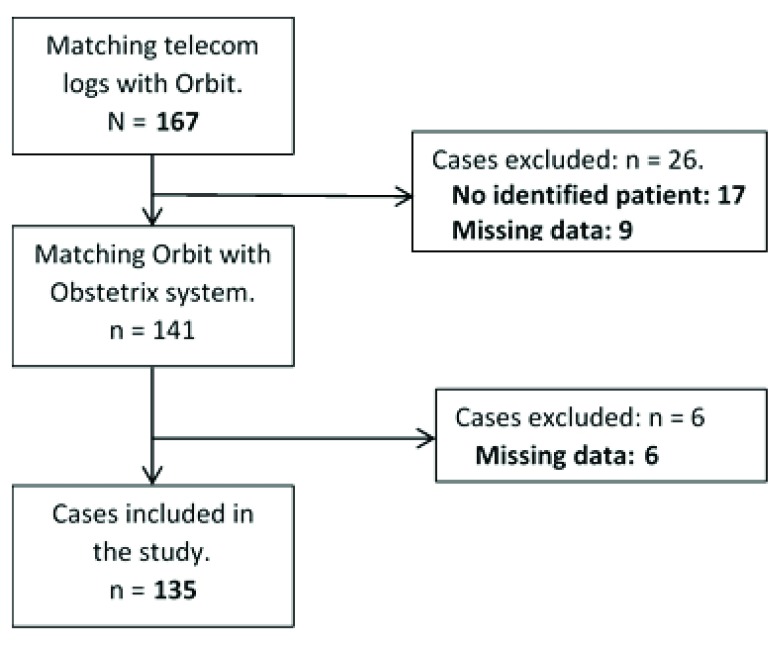
Patient inclusion.